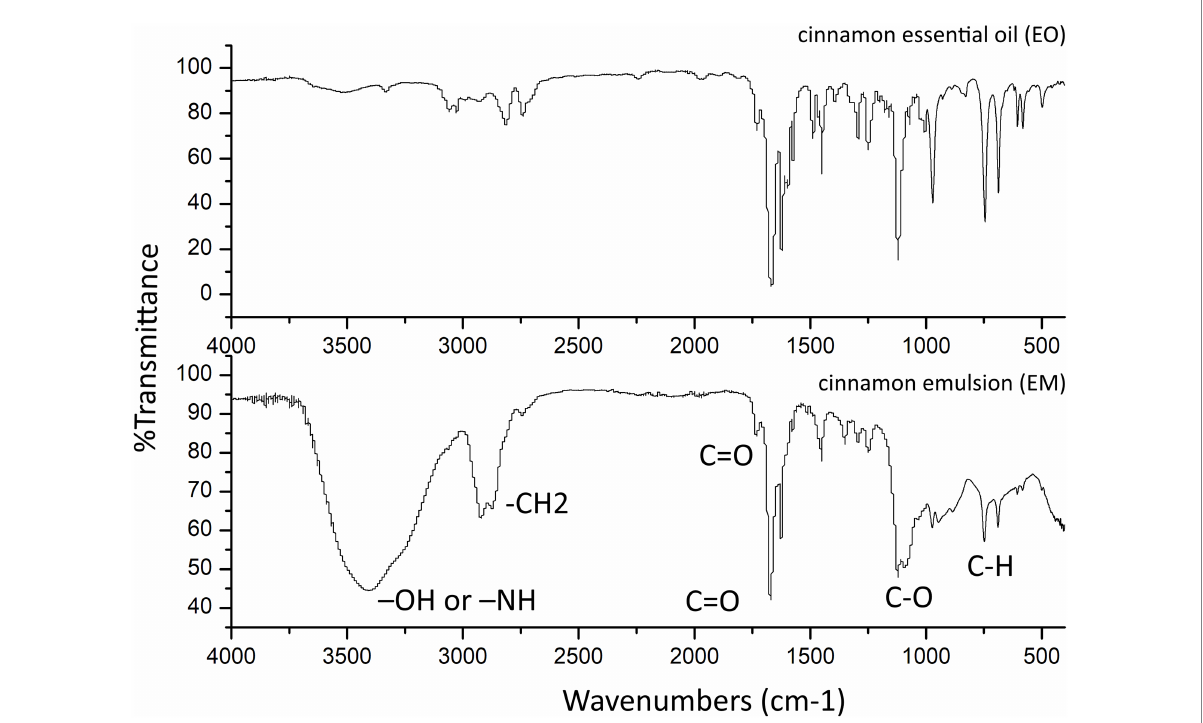
FIGURE 2 Fourier-transform infrared spectroscopy spectra of the cinnamon essential oil and as prepared cinnamon emulsion.